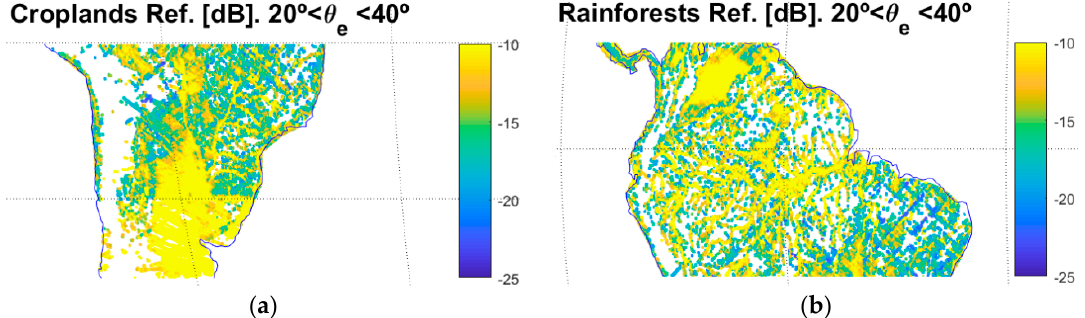
Figure 3. Close-up of one-month (from 20 September to 20 October 2017) averaged CyGNSS bistatic reflectivity Γ LHCP,CyGNSS for a grazing angle geometry with 20 ◦ < θ e < 40 ◦ , over differentiated target areas over land: ( a ) croplands, and ( b ) Amazonian rainforests. At this geometry, the major axes of the Fresnel zone is ≈ 1.6 km.